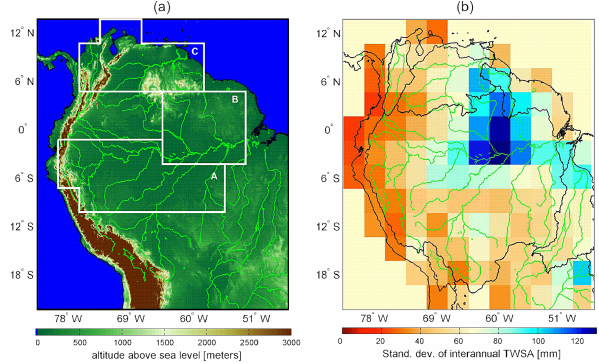
Figure 1. (a) Tropical South America’s topography and river net- works overlaid with the boundaries of the three subregions consid- ered in our analysis. Region A consisted of the central and west- ern Amazon and encompassed some of the “Arc of Deforesta- tion” that has experienced rapid rates of forest cover loss over the last decade. Region B spanned the northeastern part of the Ama- zon Basin, including many floodplain areas. Region C in northern South America included the Orinoco Basin. (b) Standard deviation of terrestrial water storage anomalies (TWSAs) interannual vari- ations as observed by GRACE for August 2002 to July 2012. A climatological mean annual cycle of monthly means was removed from the TWSA time series prior to computing the standard de- viation of the interannual variations. Contours of the main water- sheds are plotted in black (b) and the main rivers and their trib- utaries are plotted in green ( a and b ). Topography information is from the 2min Global Relief Data (ETOPO2, 2001, available at